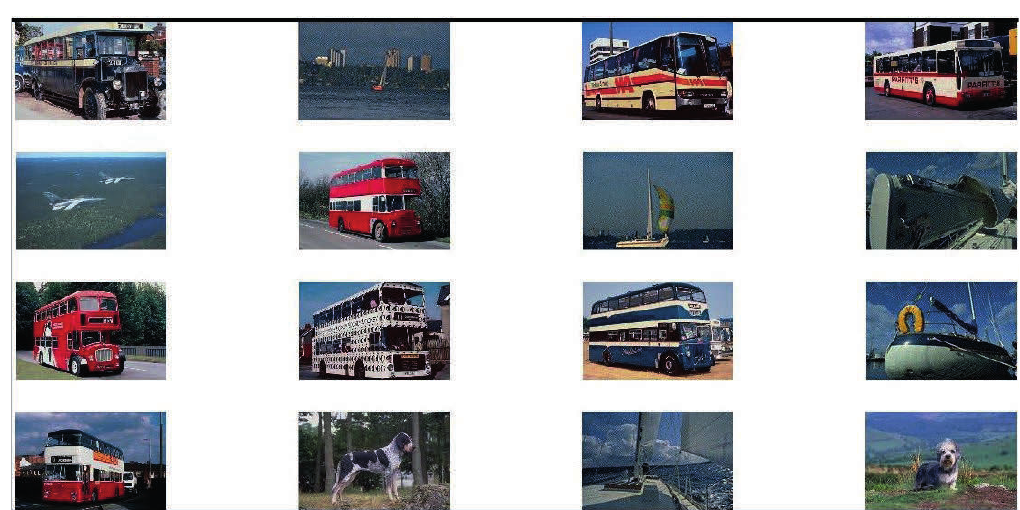
Fig. 18. Bus images retrieved using CLD based